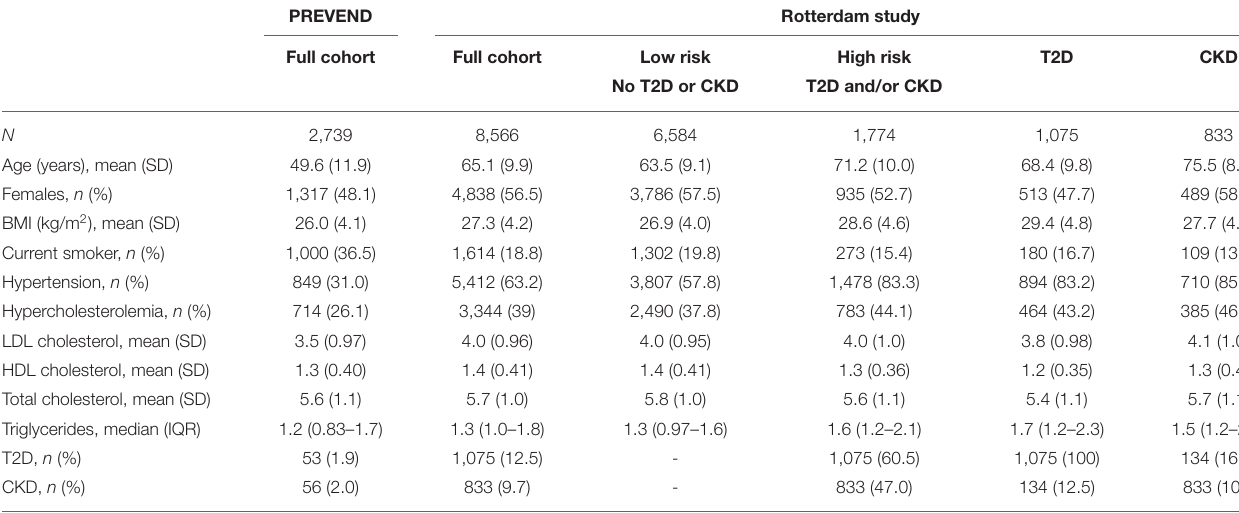
TABLE 1 | Baseline characteristics of the PREVEND cohort and the Rotterdam Study (full cohort and subgroups). PREVEND Rotterdam study Full cohort Full cohort